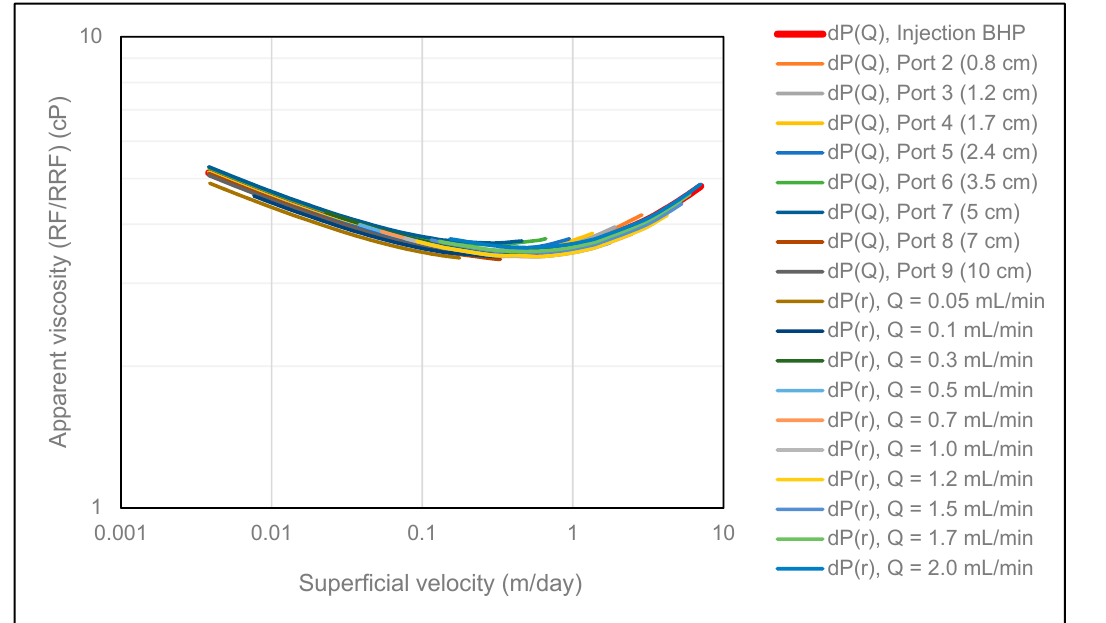
Figure 9. Summary of polymer in situ rheology obtained from both history match methods.